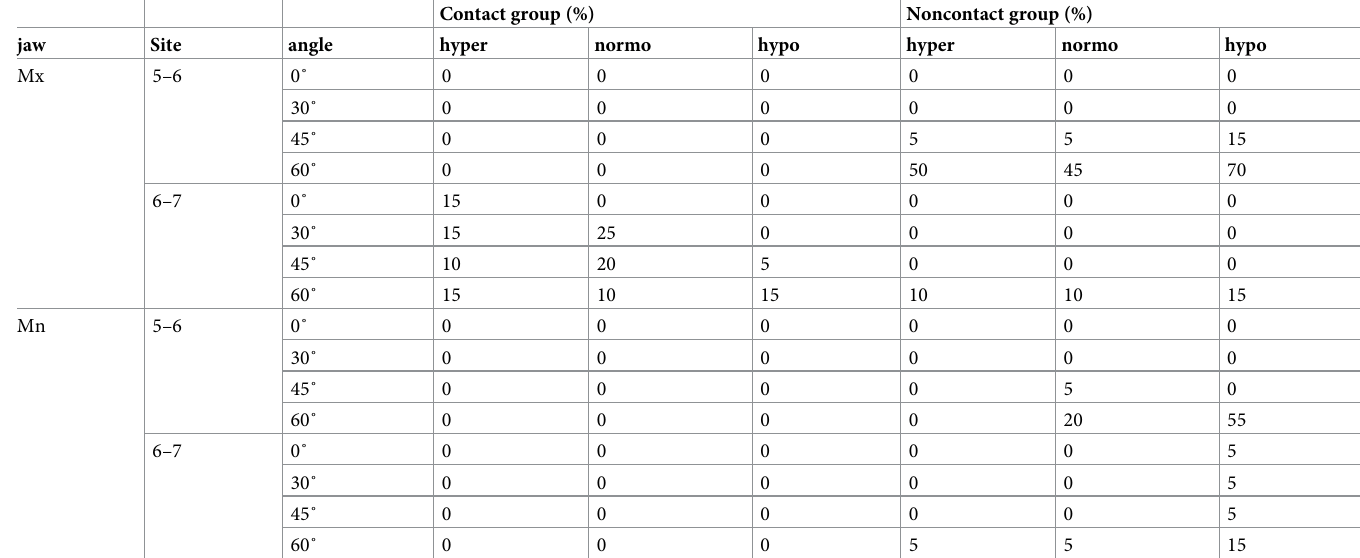
Table 5. The rates of non-measurable cases (contact group, noncontact group) at each miniscrew placement site and angle (unit: %). Contact group (%)